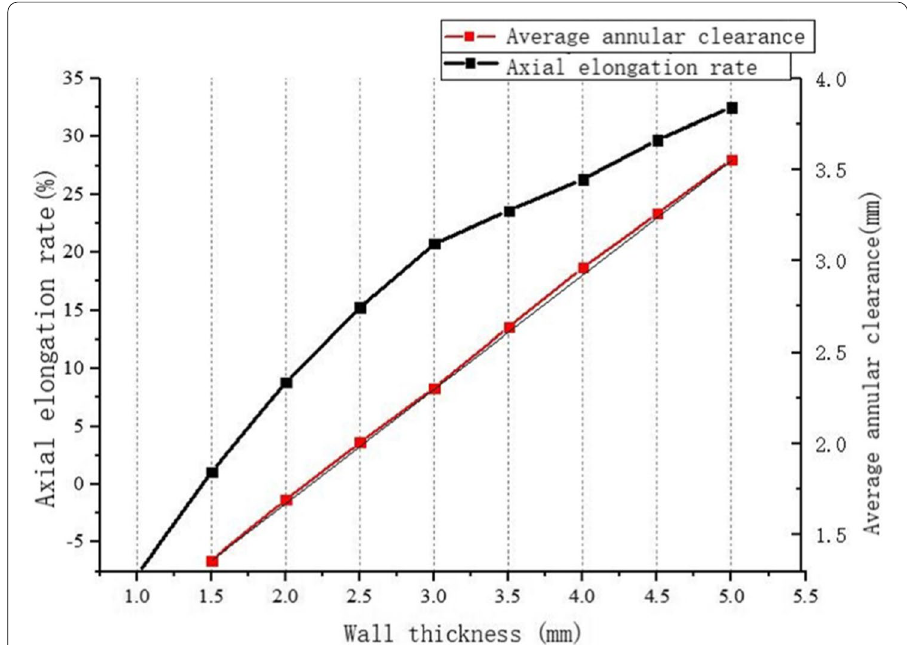
Fig. 7 Relation curves of axial elongation rate, average annular clearance, and wall thickness of rubber cylinder